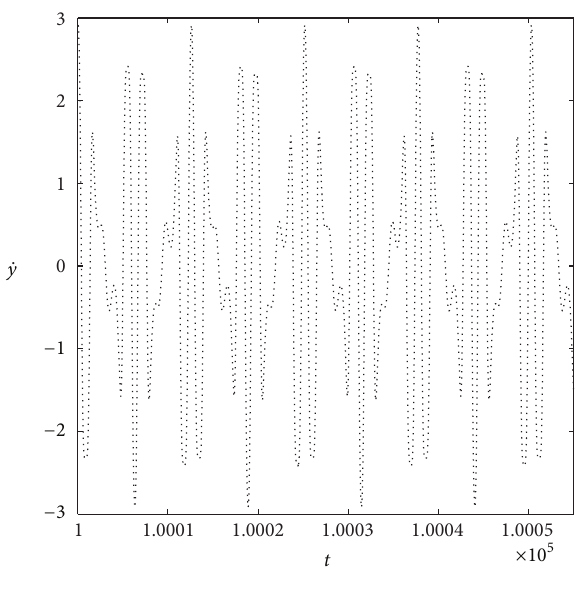
Figure 10: Time history curve (𝑡, ̇𝑦)